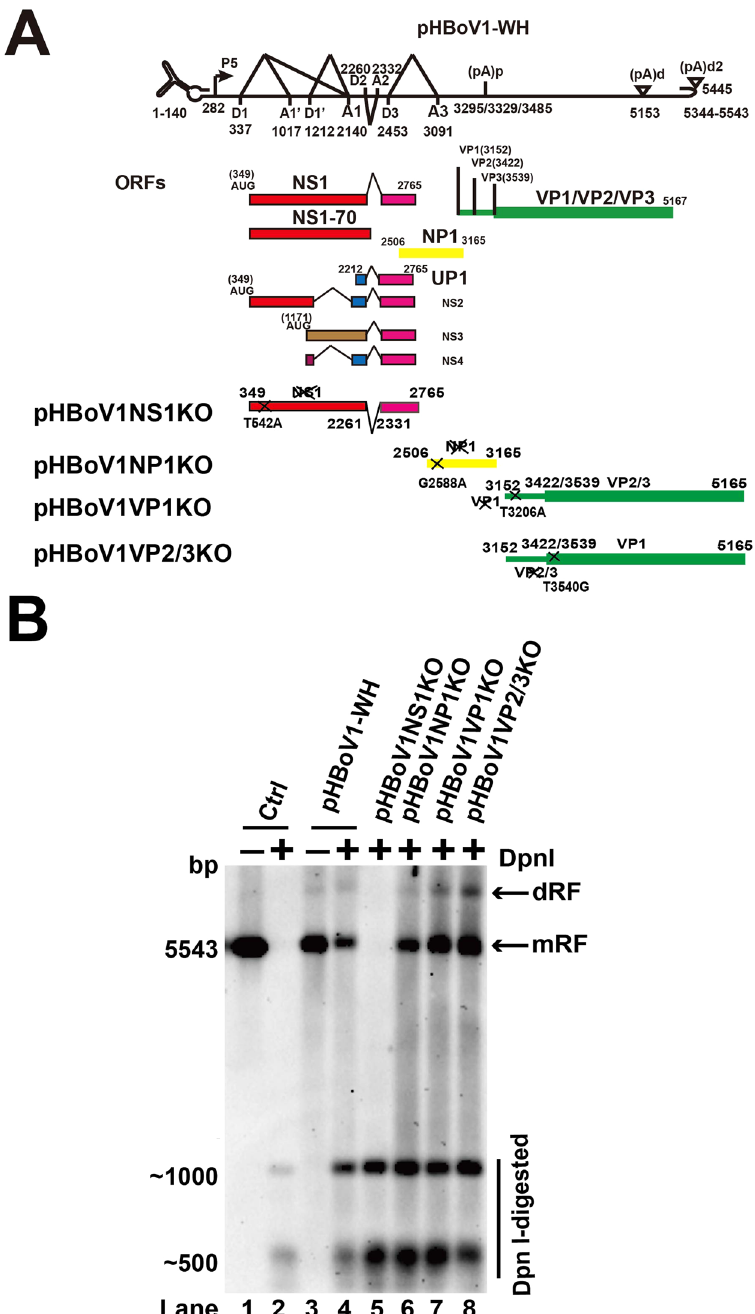
Figure 1. NS1 was required for HBoV1 genome replication. ( A ) Transcription map of HBoV. The P5 promoter, splicing donor sites ( D ), splicing acceptor sites ( A ), proximal polyadenylation site (pA)p and distal polyadenylation site (pA)d are depicted. The numbers denote the nucleotide positions in HBoV genome. Single nucleotide mutation to disrupt the open reading frame of non-structural (NS1, NP1) and structural protein (VP1, VP2/3) is indicated. ( B ) Southern blot analysis. HEK293T cells were transfected with plasmids as indicated and low molecular weight DNA was isolated post-transfection 48 hrs. Dpn I digested DNA fragments were separated by 1% agarose gel, followed by transferring to Hybond-N + membrane. The signal was detected by hybridization with an HBoV1 genome DNA probe spanning from nt 1 to nt 5543. Lane 1 and lane 2 show the Dpn I undigested or digested bands of HBoV DNA as a control and a size marker. mRF, mono replicative forms; dRF, double stranded replicative